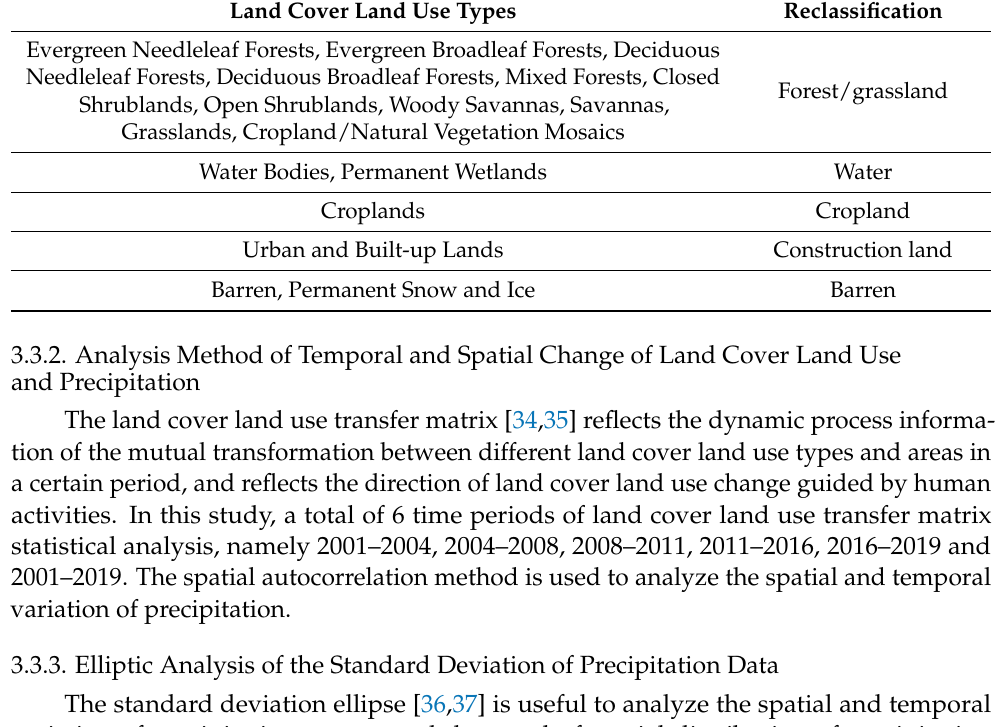
Table 1. Land cover land use types and reclassification. Land Cover Land Use Types